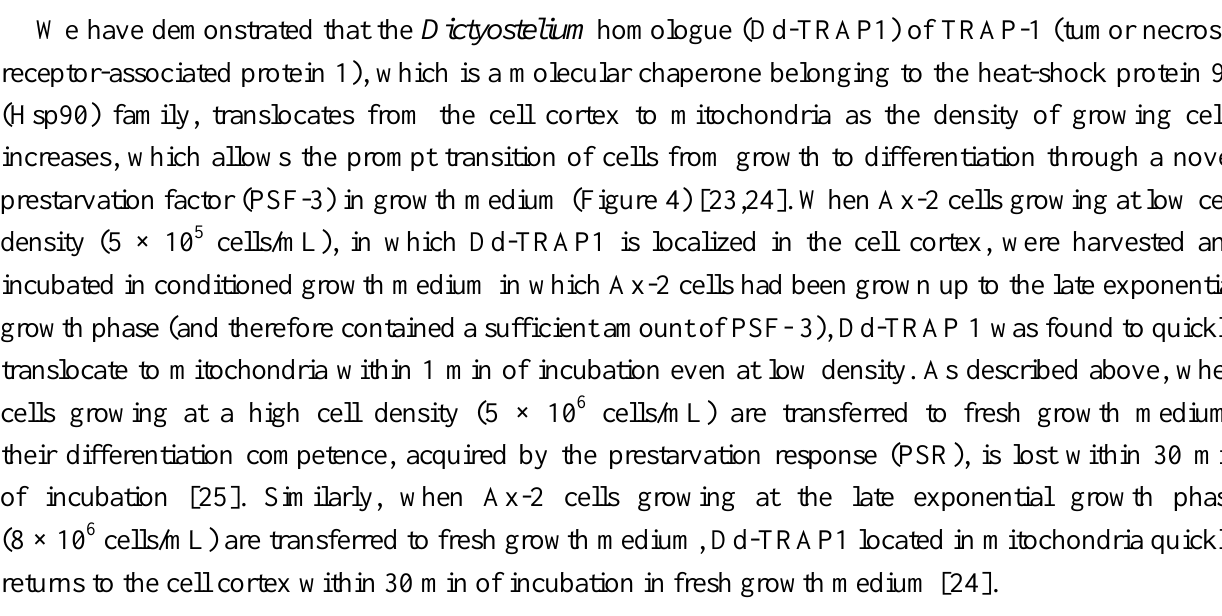
Figure 4. Schematic drawing showing the behavior of Dd-TRAP1 during the prestarvation response (PSR) and the initiation of differentiation in Dictyostelium cells (See the text for